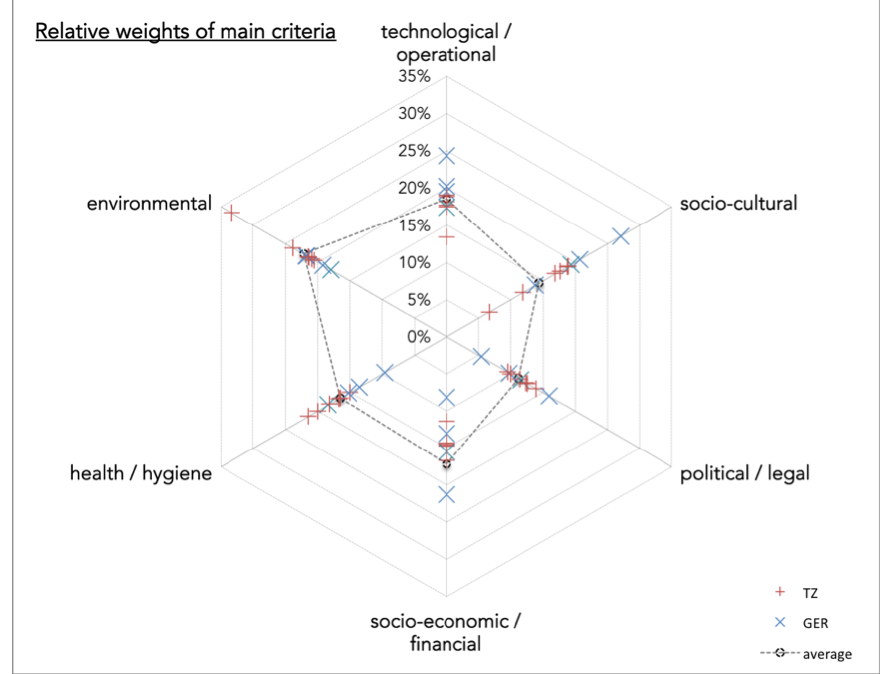
Figure 3. Colour-coded scatter plot of the relative weights of the main-criteria (in%) of Tanzanian (red) and German (blue) participants alongside the mean of all participants (grey). [The sum of all six main-criteria is 100%.]